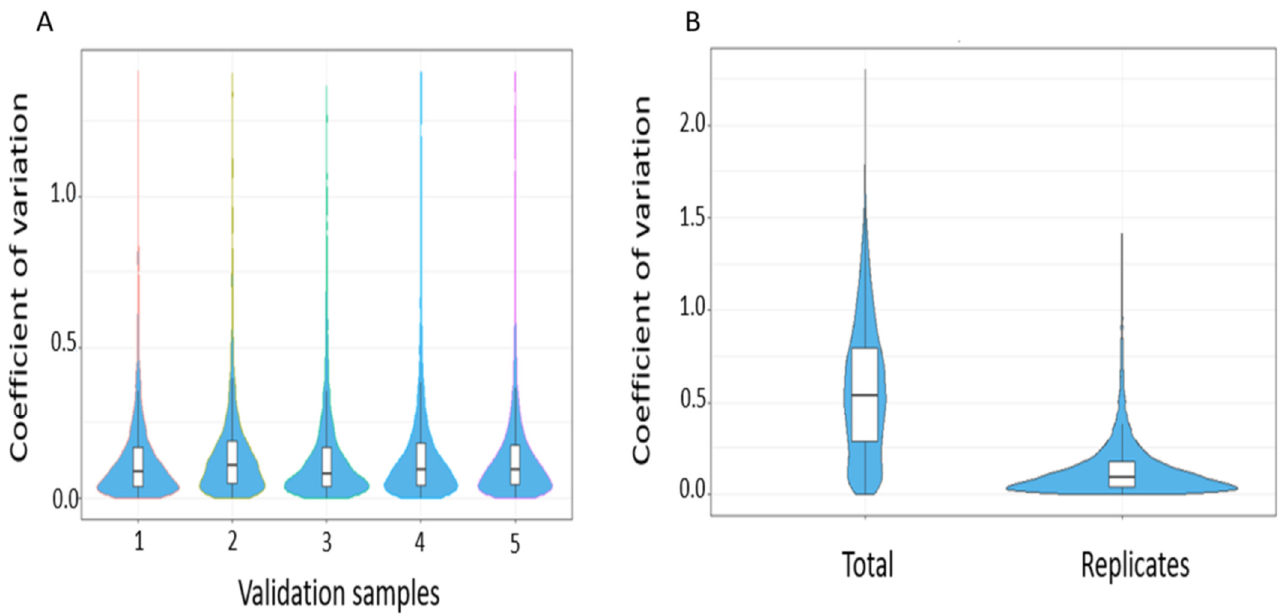
Figure 8. ( A ) Intra-assay coefficient of variation across validation samples ( B ) Summary coefficient of variation comparing total versus within replicates.